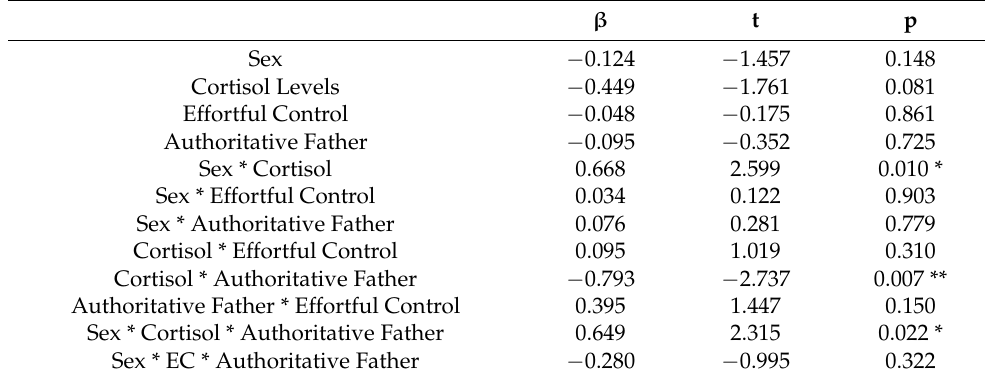
Table 4. Regression analysis for aggressive behavior including authoritative father and effortful